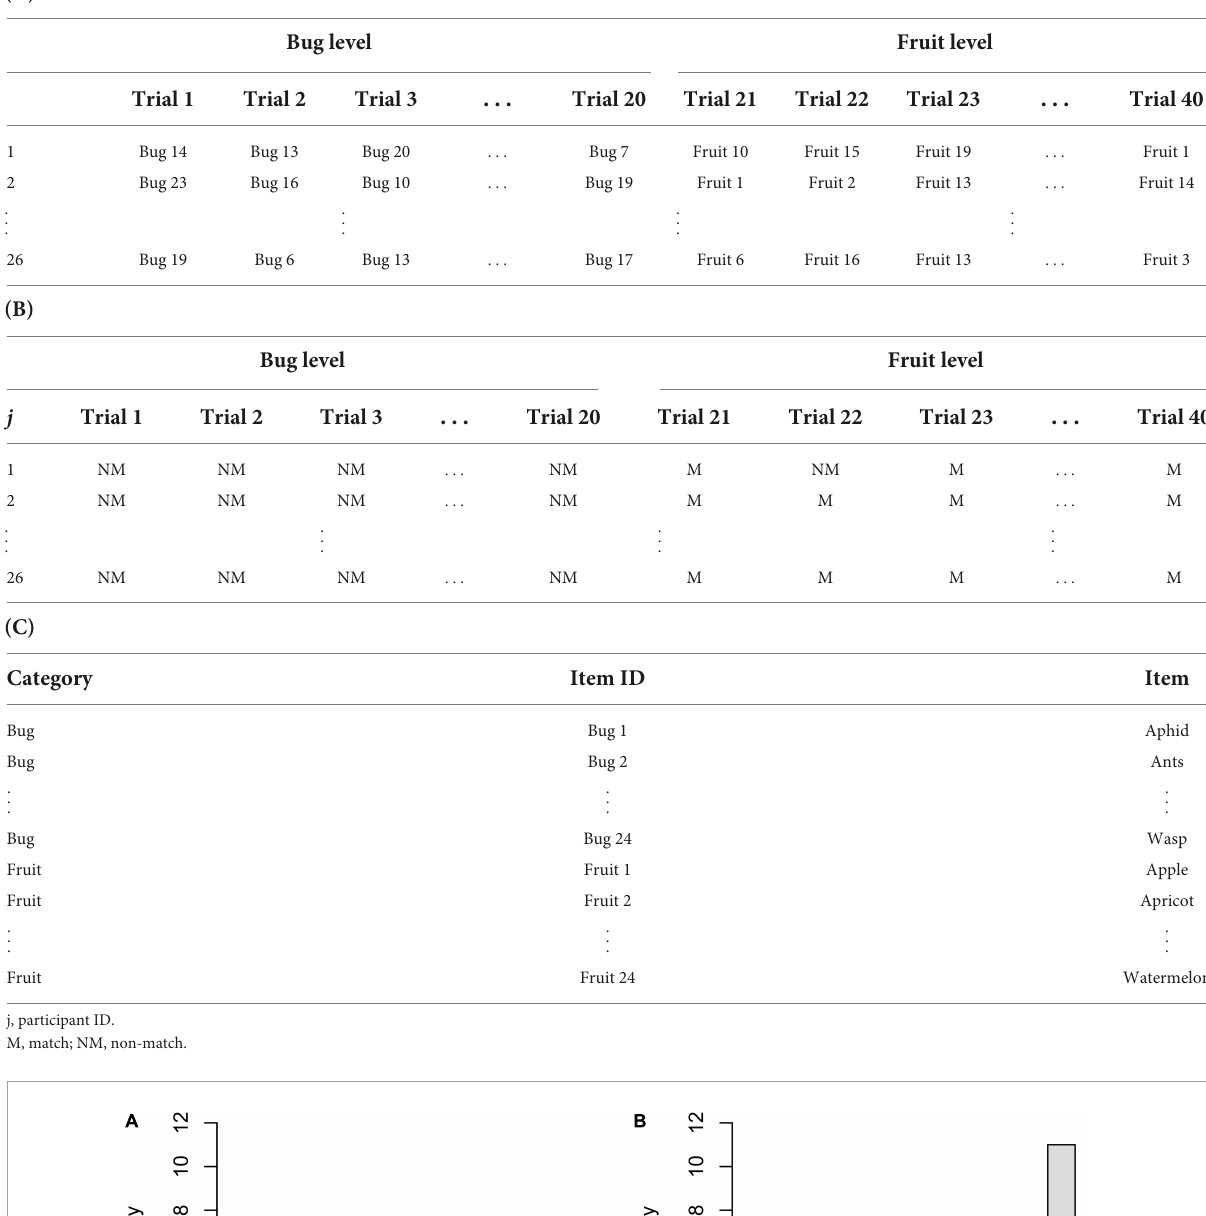
TABLE 3 Structure of the presented stimuli (A), responses (B), and item lists (C) of Nosek and Banaji (2001).